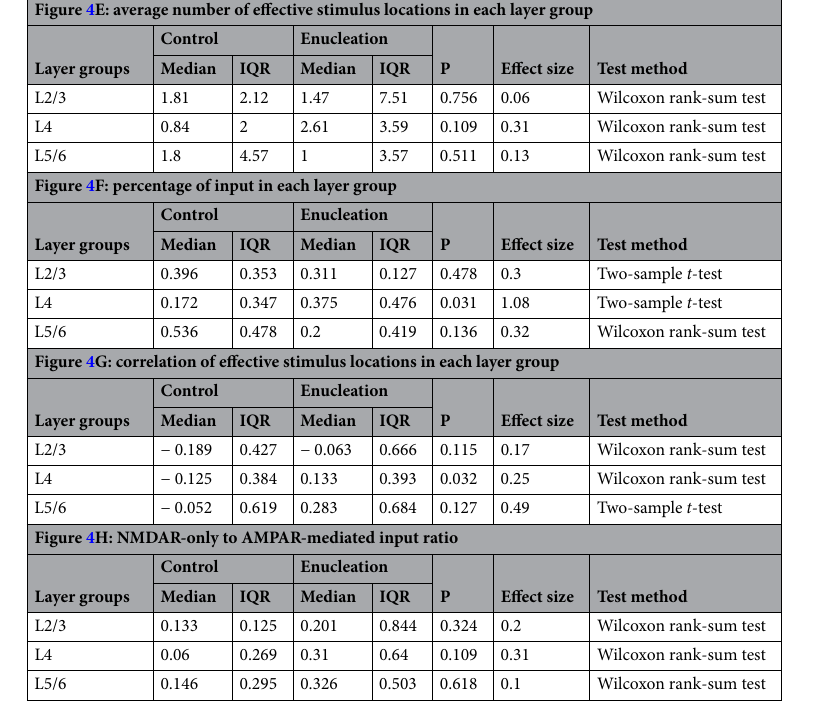
Table 4. Statistics in Fig. 4. IQR interquartile range.